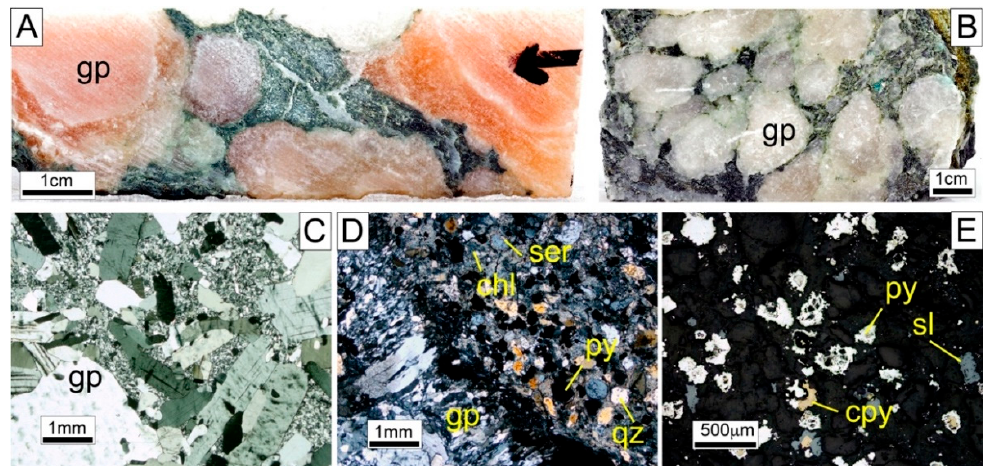
Figure 5. Hand sample photographs ( A , B ) and thin section photomicrographs (transmitted light, crossed polars: ( C , D ); reflected light: ( E )) illustrating textures and mineralogy of the gypsum- and anhydrite-rich levels hosting disseminate mineralization atop the stockwork zone. ( A , B ) Pink and white cm-sized gypsum nodules are embedded in a green, fine-grained matrix; ( C ) massive aspect of a monomineralic gypsum nodule, formed by euhedral and subhedral mm-sized crystals in a fine-grained matrix; ( D ) detail of the contact between a gypsum nodule and the rock matrix, which is composed of crystals of anhydrite, quartz, plagioclase (altered to sericite), chlorite and a dissemination of sulfides; ( E ) pyrite is the most abundant sulfide mineral in the matrix of the gypsum-rich levels and appears as dissemination of cellular, framboidal and atoll-like crystals and grains along with sphalerite and chalcopyrite. Abbreviations: chl = chlorite; cpy = chalcopyrite; gp = gypsum; py = pyrite; qz = quartz; ser = sericite; sl = sphalerite.